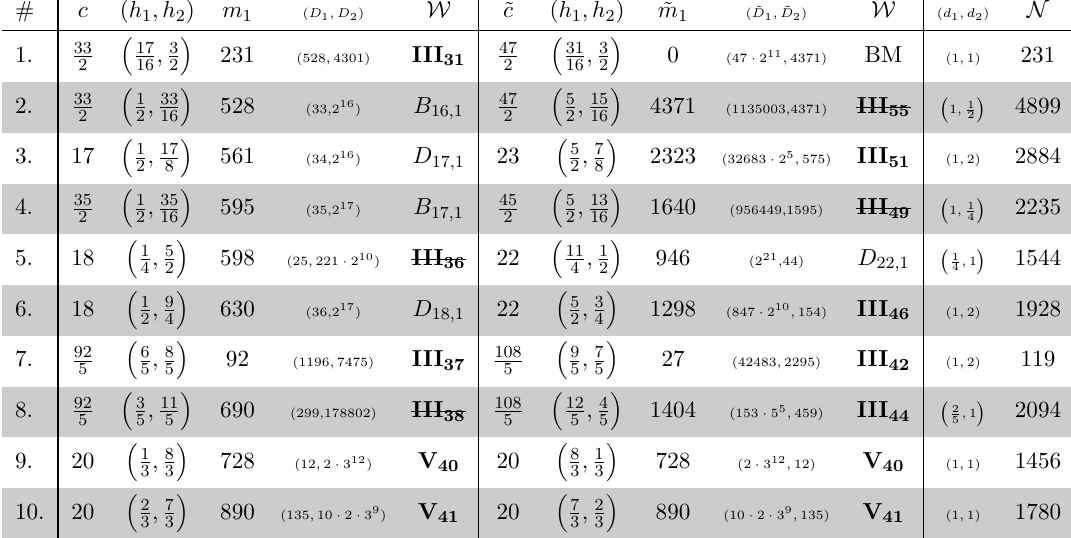
Table 25. Inconsistent pairings, c H = 40 with ( n 1 , n 2 ) = (3 , 3) . The meromorphic character is j 2 3 ( j − 1240 + N ) with N given in the last column of the table.